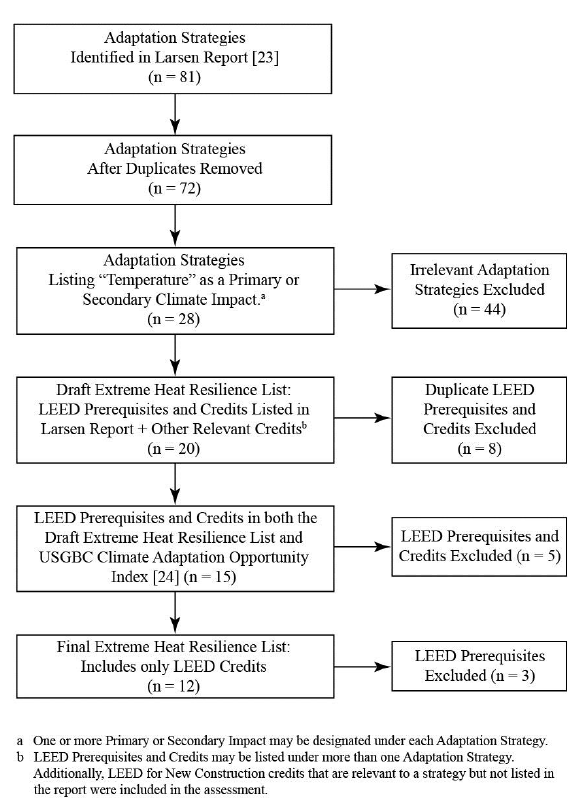
Figure 2. Flow chart of LEED Credit inclusion criteria. Diagram adapted from the Preferred Reporting Items for Systematic Reviews and Meta-Analyses (PRISMA) Flow Diagram [26].